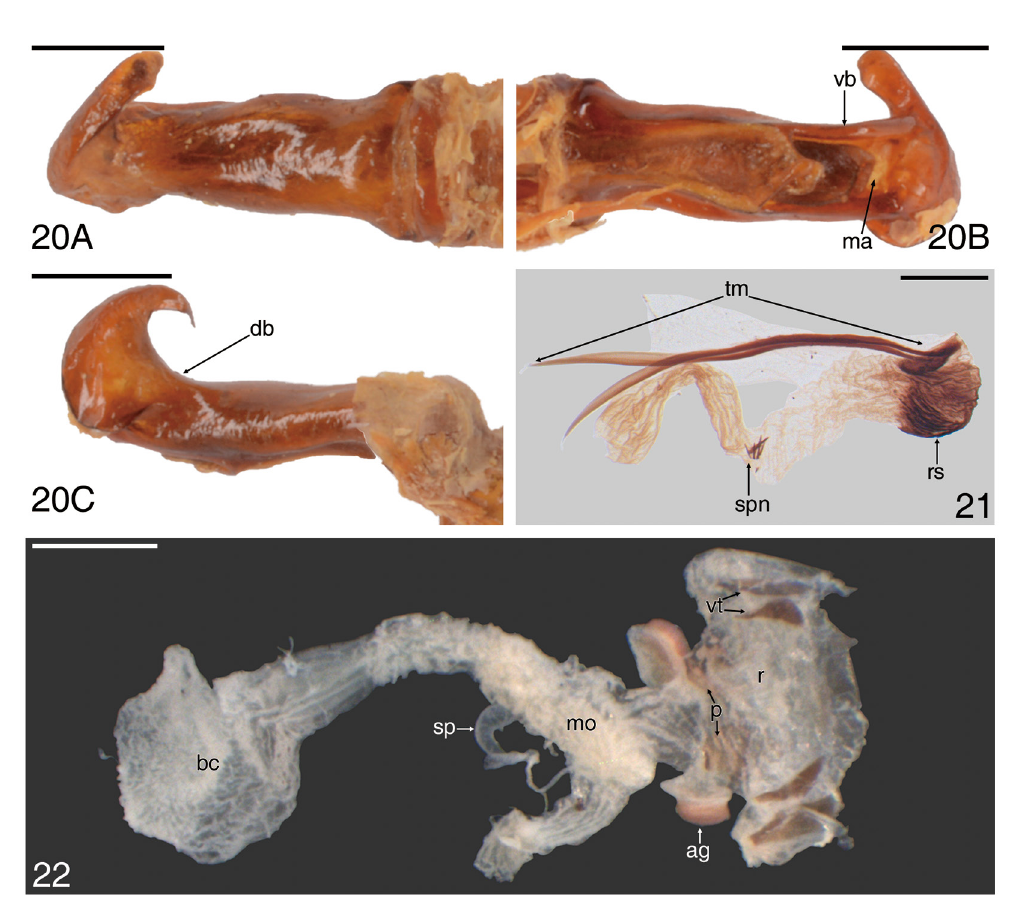
Figs 20–22. Morphotype VIII “ Scutata ”. 20 . Male genitalia of M. scutata (Reitter, 1902), lectotype (MFNB), parameres in dorsal (A), ventral (B) and lateral (C) views. 21 . Endophallus and temones of M. lassallei Keith, 2010, holotype (DKC) in lateral view. 22 . Female genitalia of M. scutata , non-type (MFNB) in dorsal view. Scale bars = 1.0